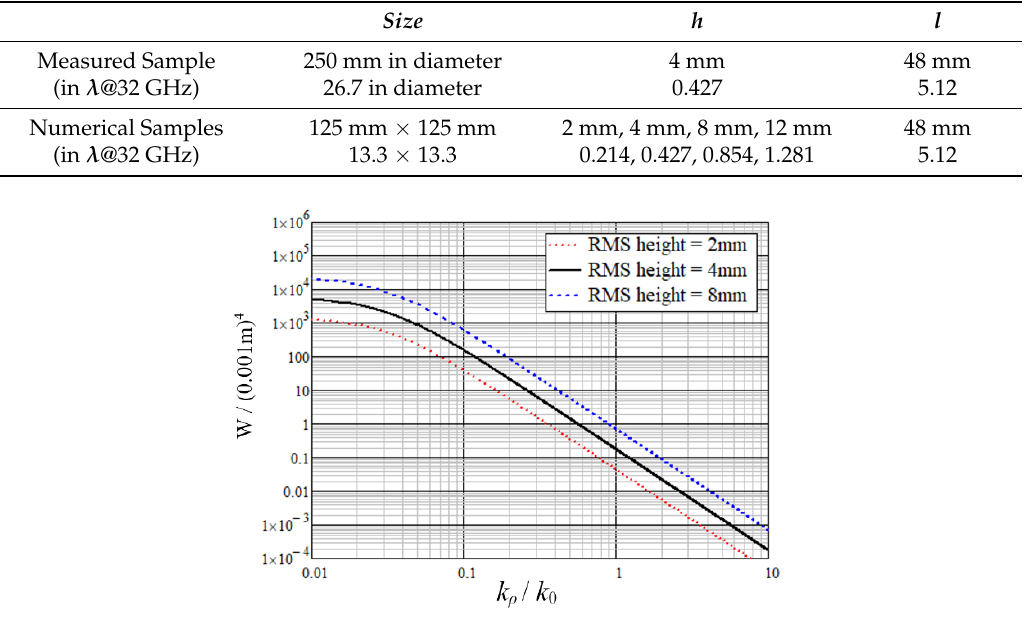
Figure 1. Surface roughness spectrum of the considered rough surface samples at 32 GHz ( k 0 = 2 π / λ ). (Exponentially correlated rough surface, correlation length l of 48 mm).